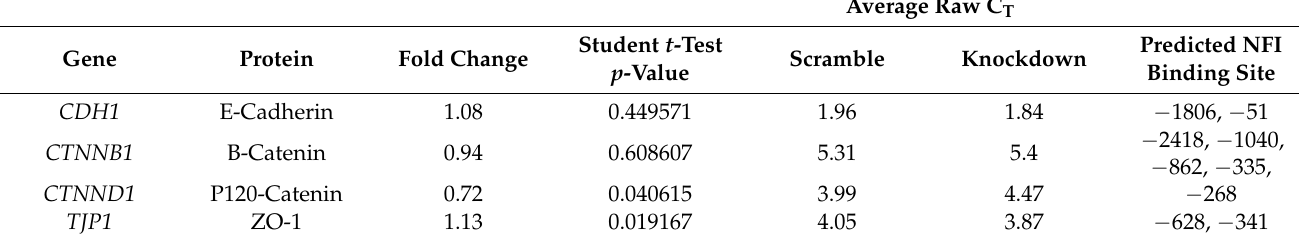
Table 3. Results of qPCR conducted against genes encoding for junction proteins which showed significant differences during line scanning analysis. CDH1 and CTNNB1 were found to have no significant differences in expression between treatment groups via t -test. CTNND1 was found to have significantly downregulated expression via t -test. TJP1 was found to have significantly upregulated expression via t -test. As assayed genes were screened against a database of predicted NFI binding sites in silico and the position of predicted binding sites reported.